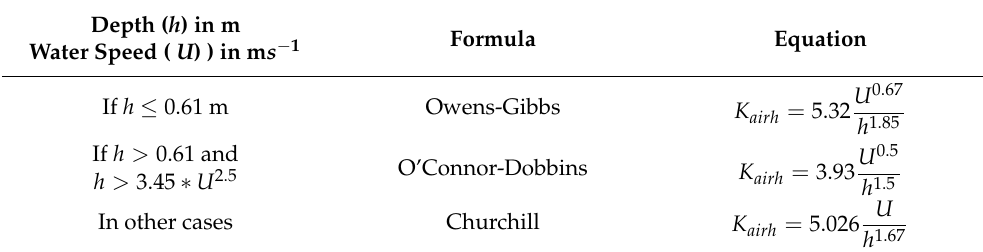
Table 1. Equations of the Covar method to estimate the reaeration constant K aeration . Depth ( h ) in